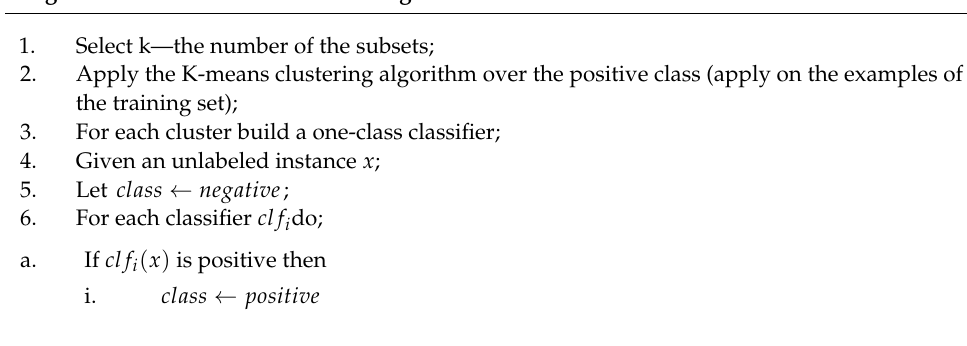
Figure 3. Illustration of the proposed method. Firstly the algorithm clusters the positive dataset into k clusters, then traisn a one-class classifier for each cluster. Given a new instance, if at least one-classifier labeled it as a positive then it will be assigned as positive, otherwise negative.